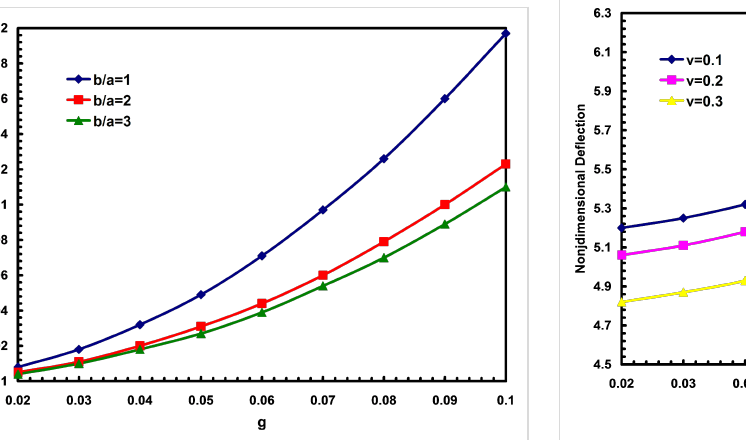
Figure 6: The effects of nonlocal parameter and Poisson's ratio on the nondimensional